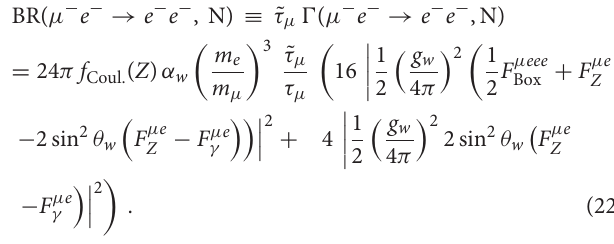
FIGURE 1 | Examples (subset) of HNL mediated diagrams contributing to some of the cLFV decays and transitions discussed in the text: nuclear µ and muonium oscillations. In the neutral fermion internal lines, i , j